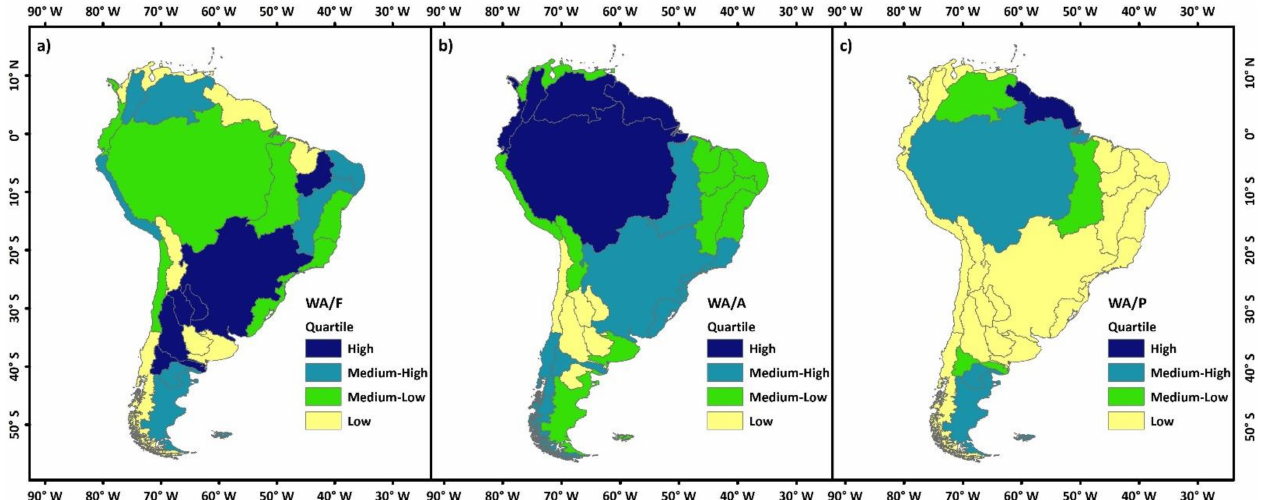
Figure 5. Water availability ratios per hydrological region mapped as quartiles ( a ) water availability per runoff; ( b ) water availability per area; and ( c ) water availability per person. See Table 2 for specific